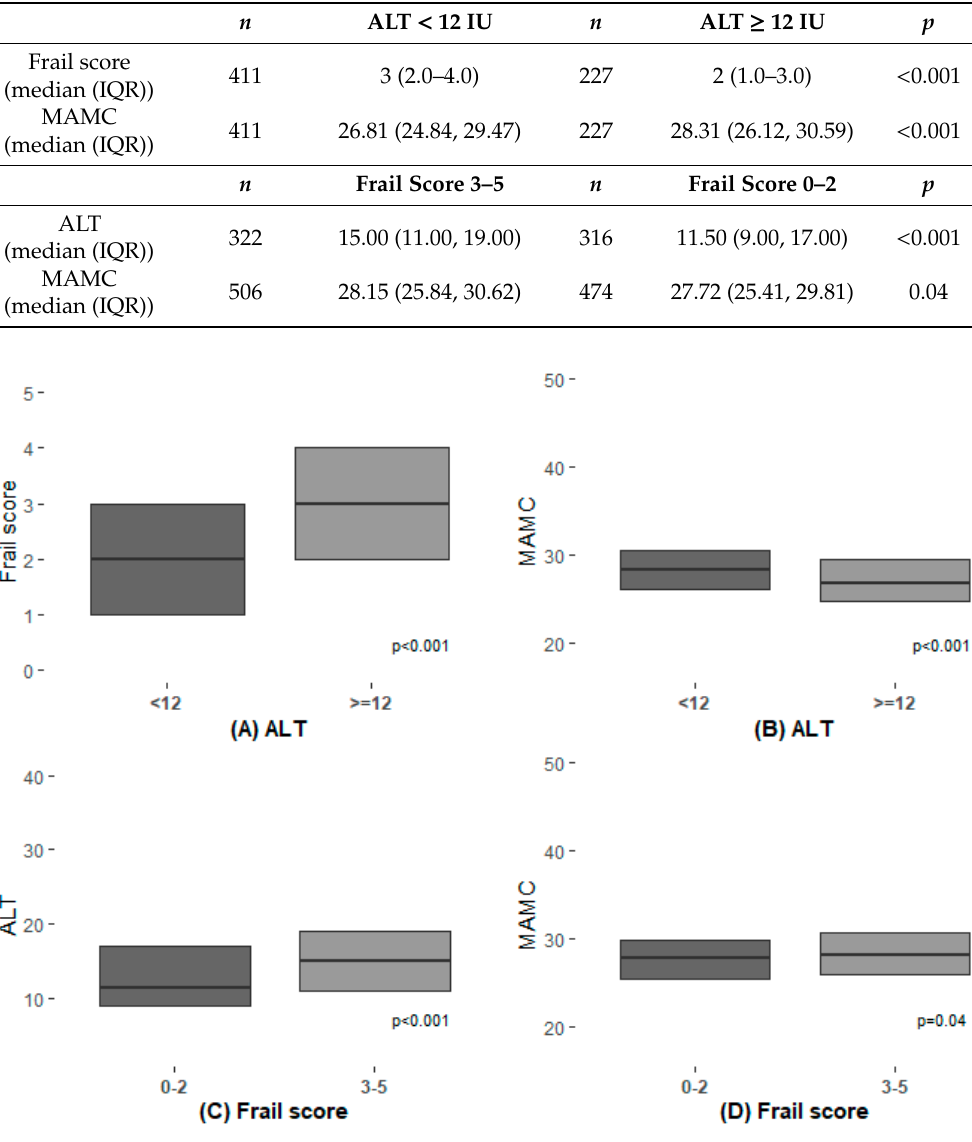
Figure 1. Associations between different sarcopenia and frailty indices.